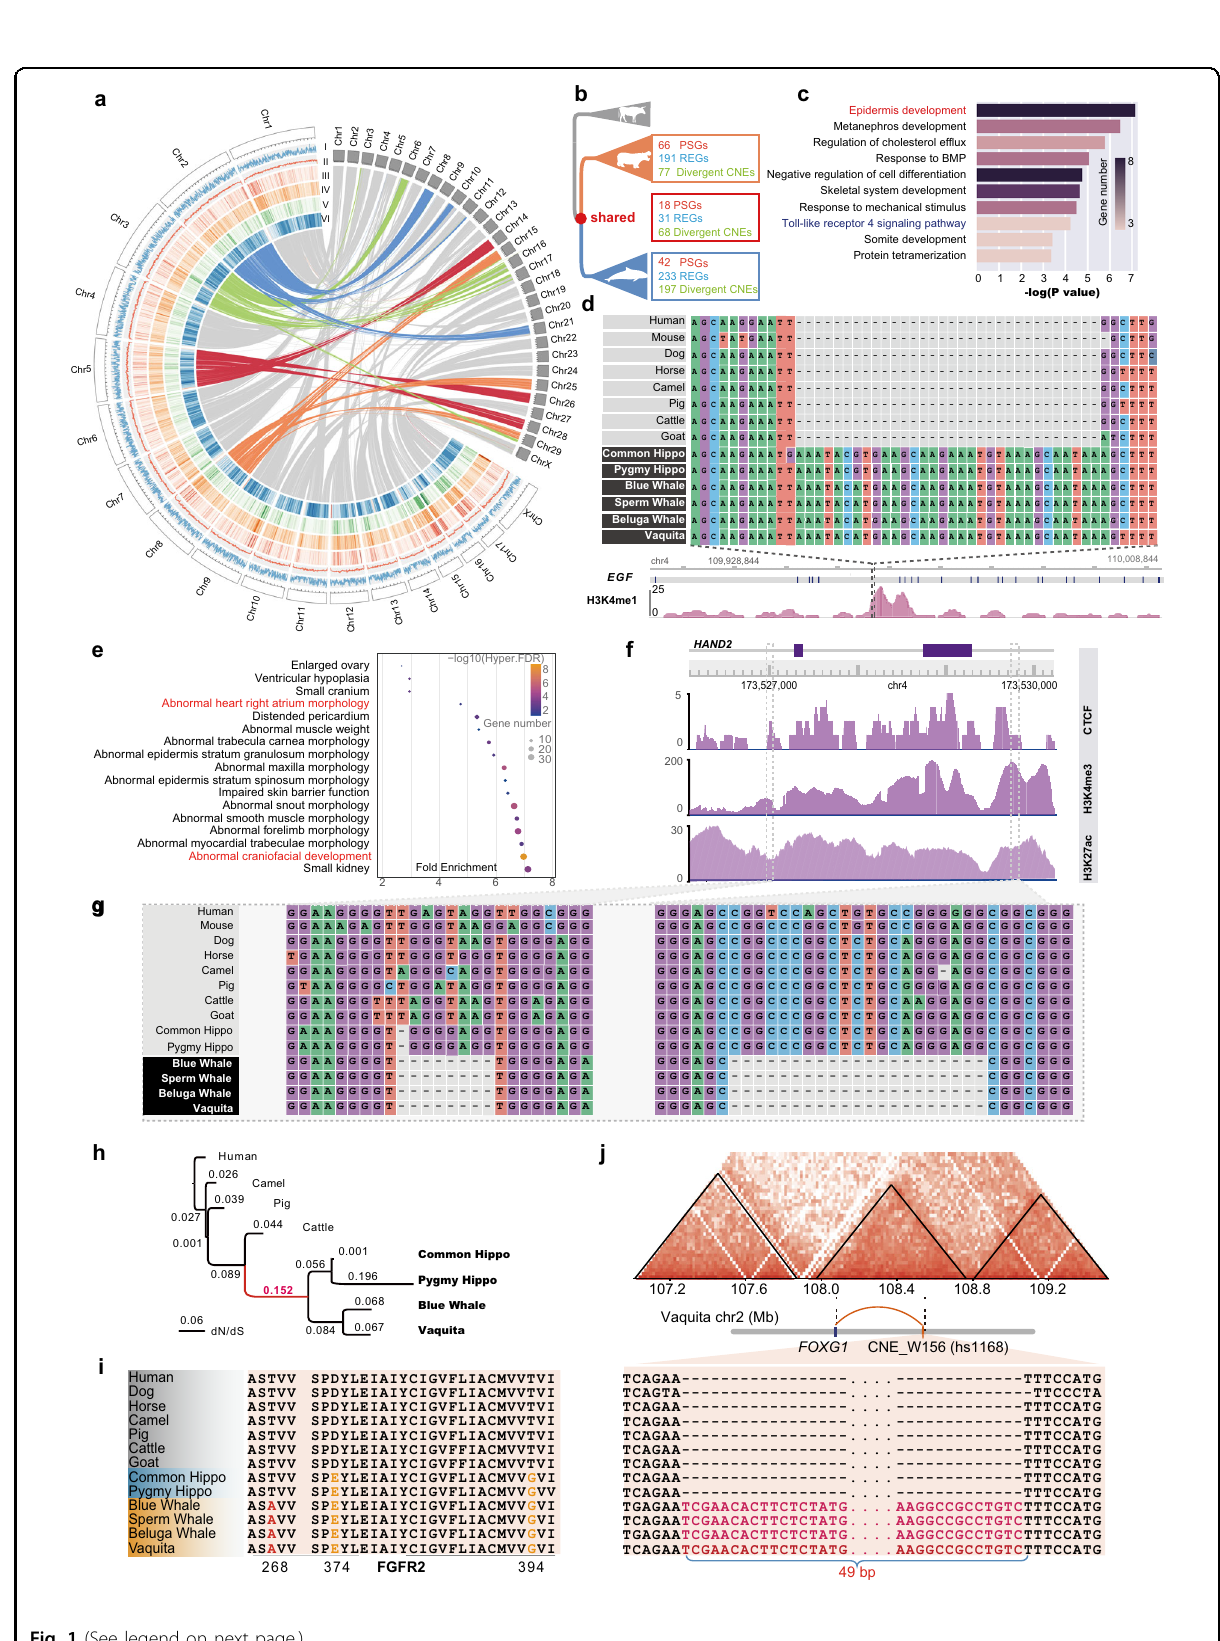
Fig. 1 (See legend on next